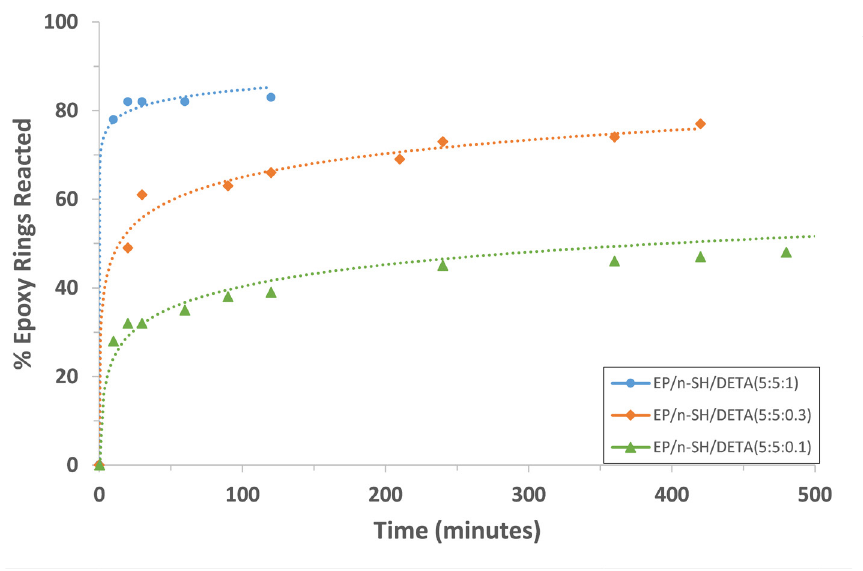
Figure 3. Epoxy rings reacted vs. time for EP/n-SH/DETA (5:5:1), EP/n-SH/DETA (5:5:0.3) and EP/n-SH/DETA (5:5:0.1) systems, at 122 o C, analyzed by FT-MIR